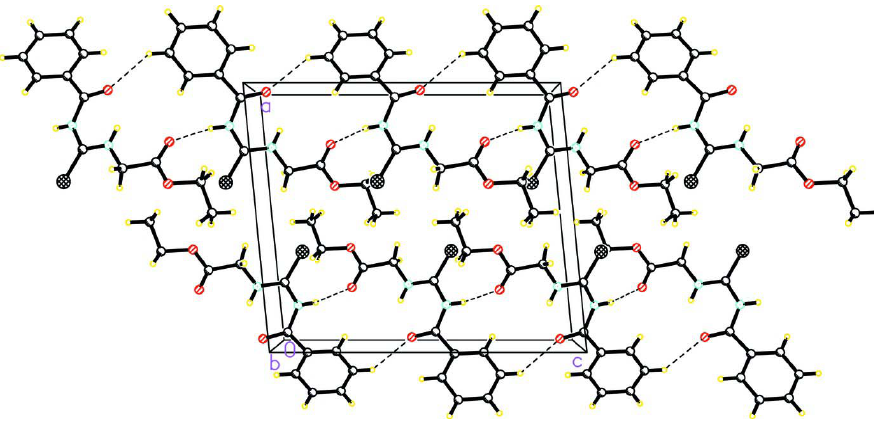
Figure 2 A packing diagram of (I) viewed down the a axis. Hydrogen bonds are shown by dashed